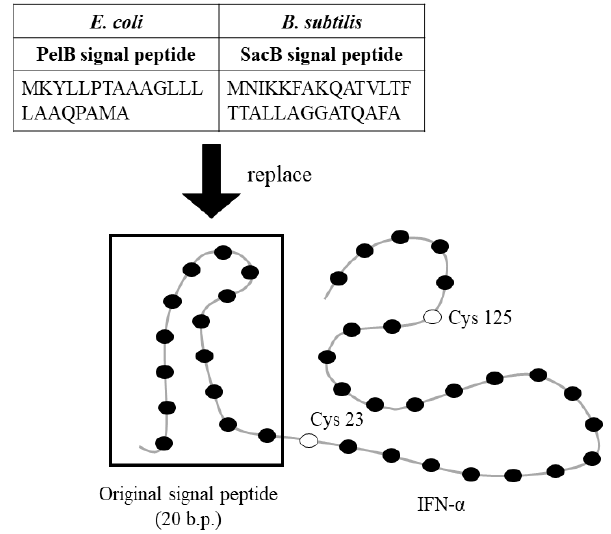
Figure 3. The design of recombinant IFN construction.